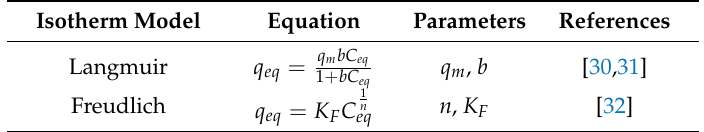
Table 2. Isotherm models investigated for the adsorption of Zn 2+ and As 3+ . Isotherm Model